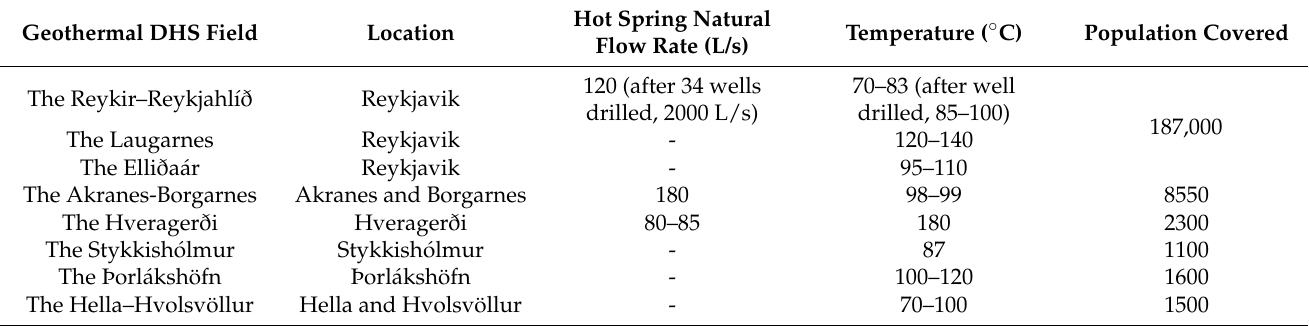
Table 1. Characteristics of geothermal district heating fields in Iceland